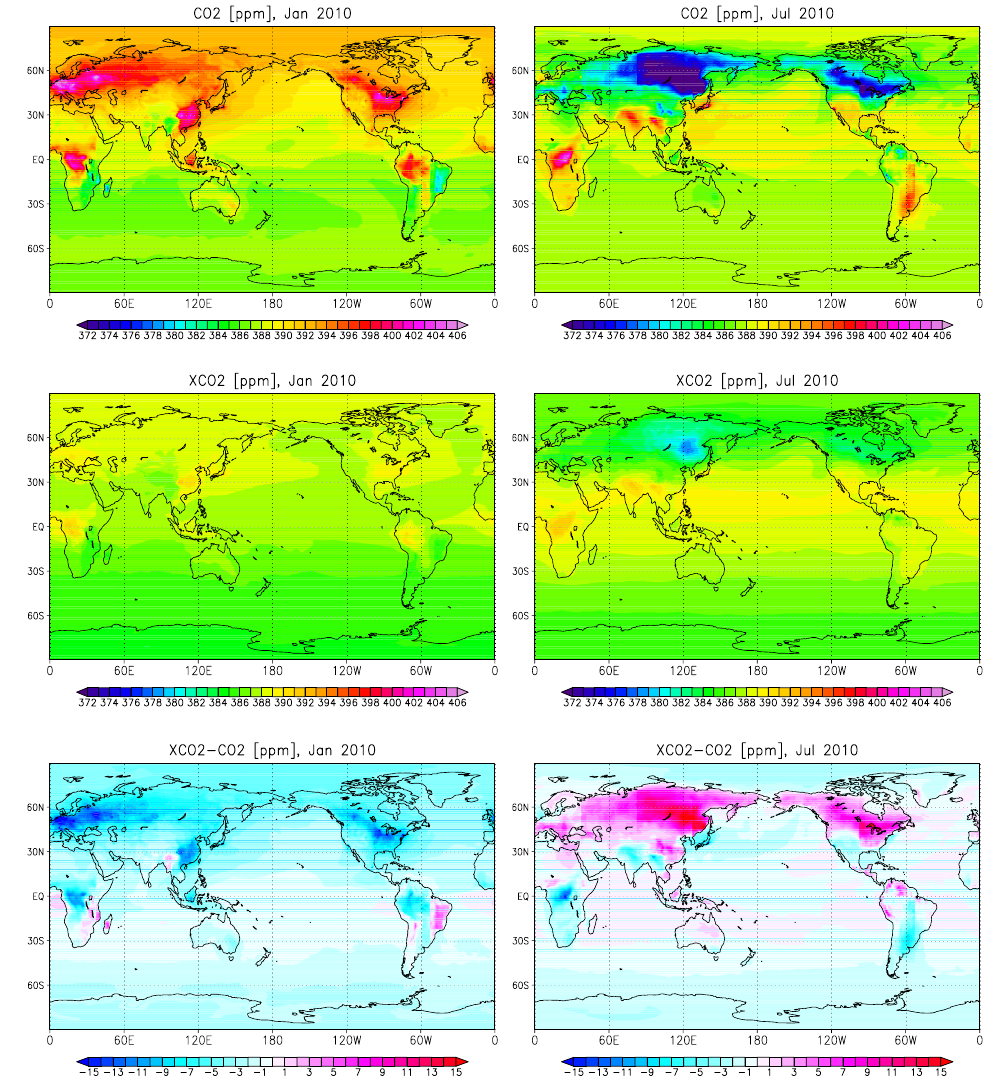
Fig. 9. Simulated monthly mean surface CO 2 (top), XCO 2 (middle) and their differences (bottom) at 13:00LT in January (left column) and July (right column) 2010. Ranges of colour scales are 372–406ppm for CO 2 and XCO 2 , and − 15 to 15ppm for the